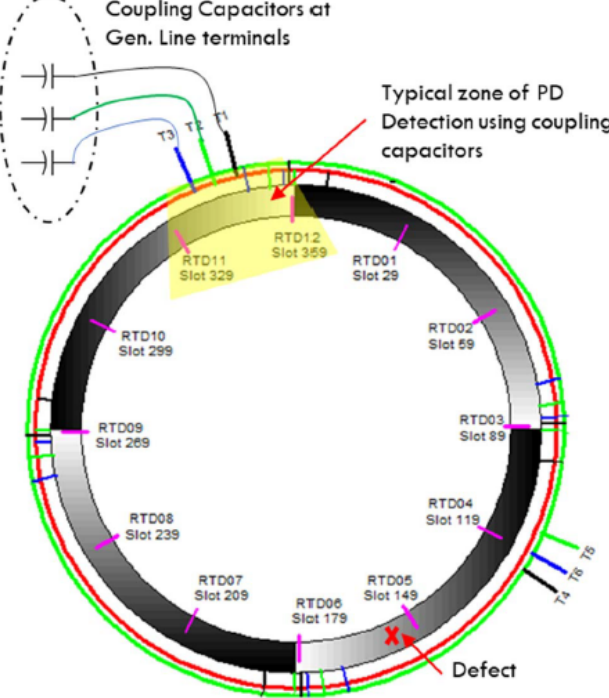
Figure 25. Typical structure of a monitoring system with RTDs